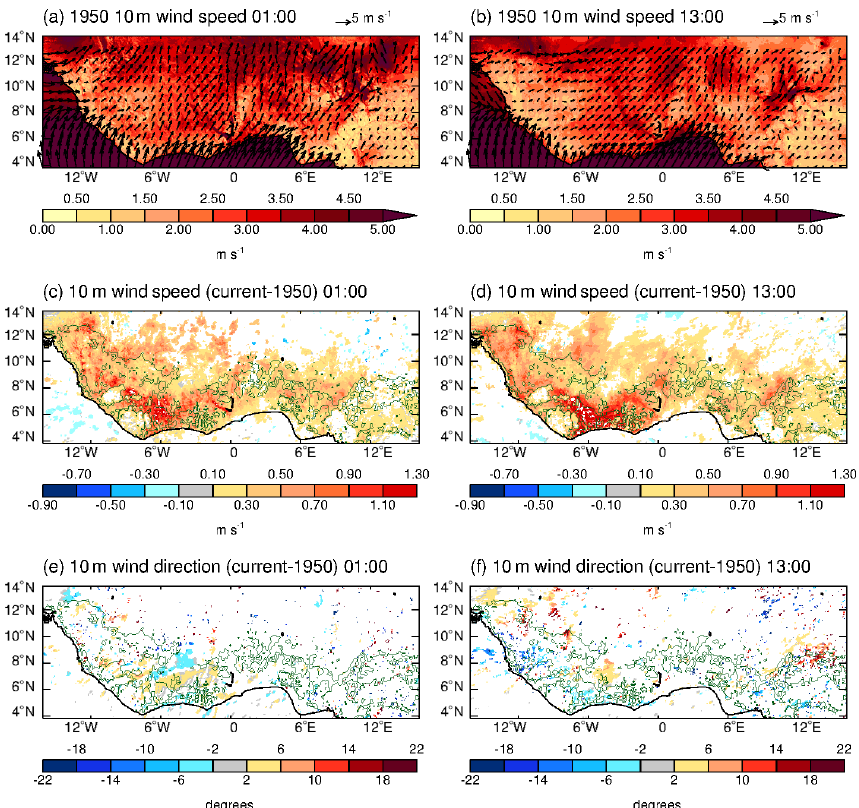
Figure 6. Winds of 10m for 01:00UTC (left) and 13:00UTC (right). The 1950 10m wind (speed in shading, direction show by vectors) at (a) 01:00UTC and (b) 13:00UTC. Changes in (c) and (d) 10m wind speed and (e) and (f) 10m wind direction. Insignificant changes are shown in white (for wind direction this is the individual pixel significance, whereas for wind speed, FDR correction has been applied), whereas small but significant changes either side of zero are shown in grey. Green contours show where there has been deforestation.